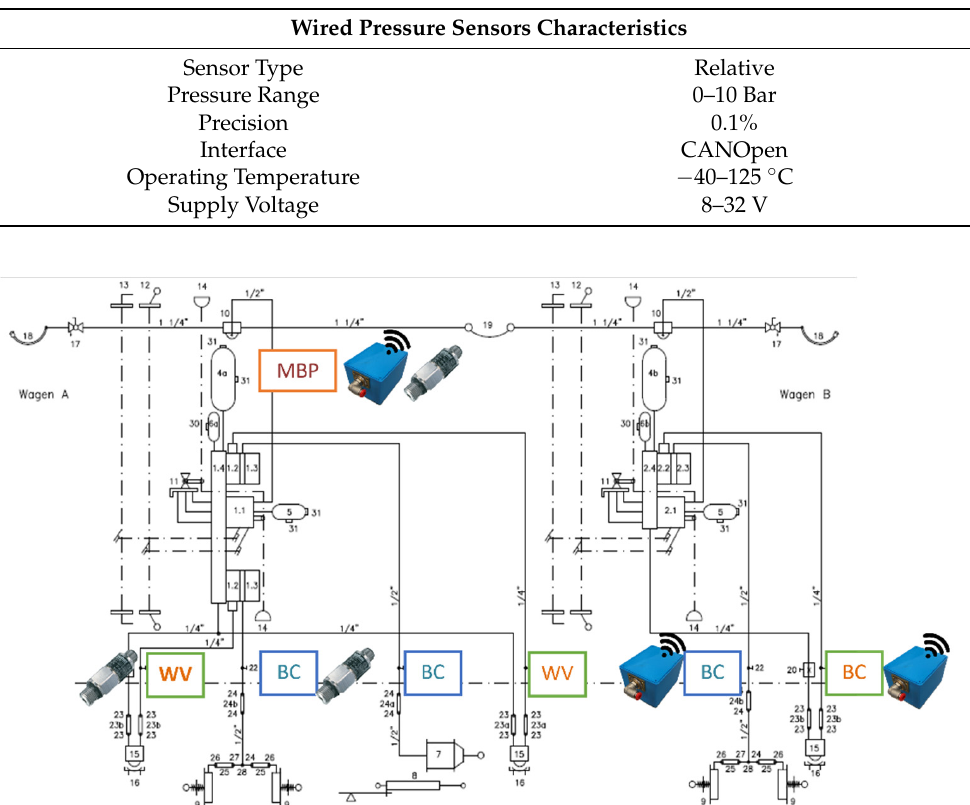
Table 5. Pressure sensor characteristics.